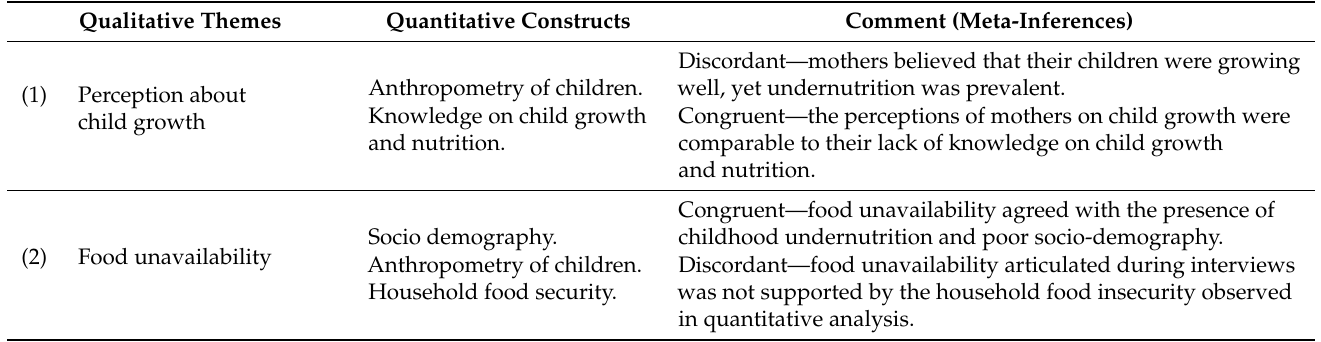
Table 3. Organising the related themes and constructs and creating a joint display